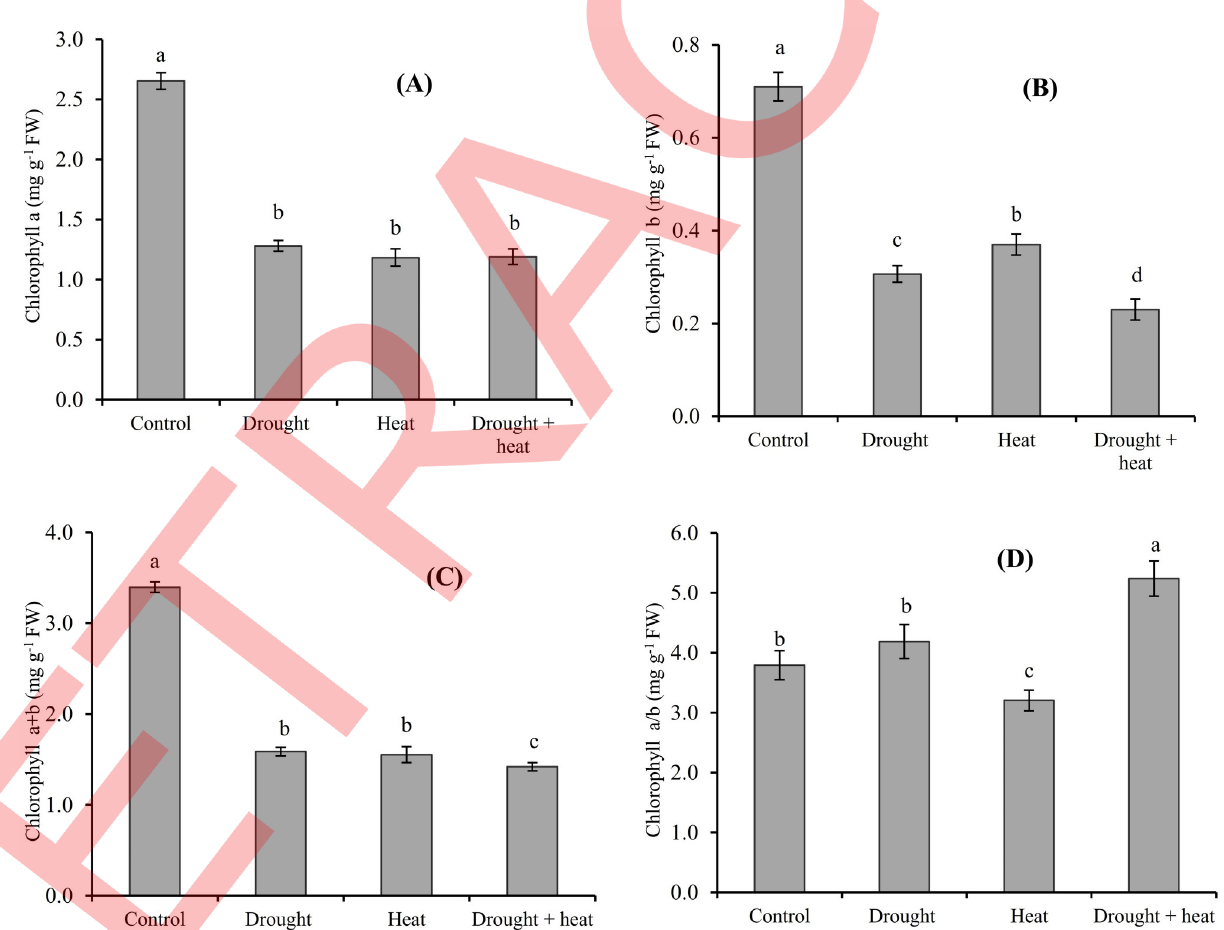
Fig 3. Effects of different drought and heat treatments on chlorophyll a (A), chlorophyll b (B), chlorophyll a+b (C) and chlorophyll a/b (D) of wheat. Values show mean ± SE (n = 3). Bars sharing the same letters are statistically at par with each other at significance level of 5% ( P � 0.05).